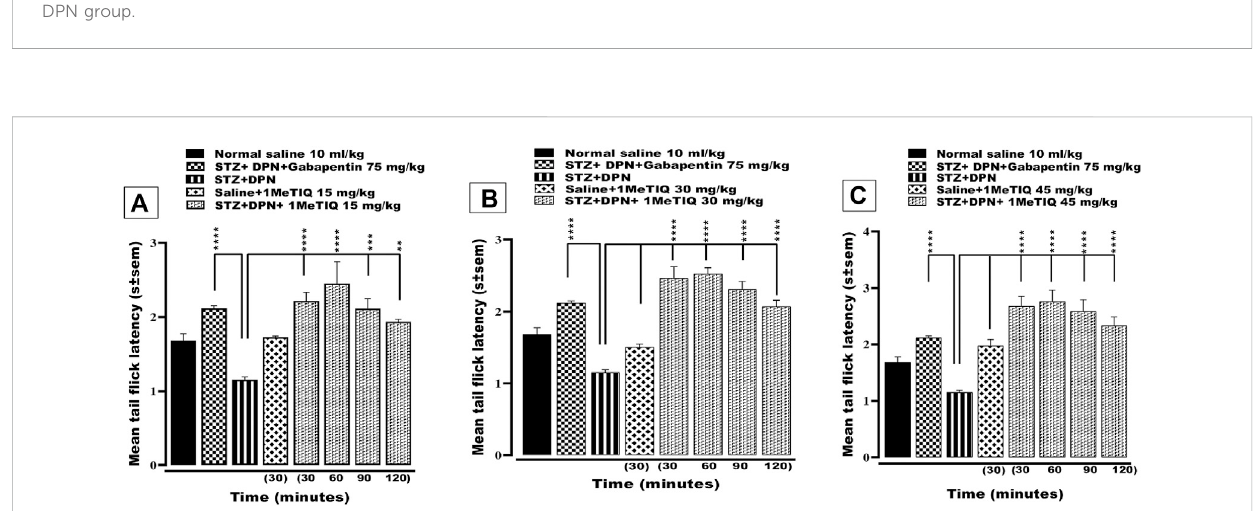
FIGURE 2 Effect of 1-Methyl-1, 2, 3, 4-tetrahydroisoquinoline (15, 30 and 45 mg/kg i.p.) or gabapentin (75 mg/kg) on STZ-induced diabetic thermal hyperalgesia. 4 weeks after STZ administration, mice exhibited signi fi cantly reduced response latencies in the tail immersion test. (A, B) and (C) , an effect that was negated by both gabapentin and 1MeTIQ. Data are presented as mean ± SEM and the abscissa coordinate represents the time after treatment. ** p < 0.01, *** p < 0.001, **** p < 0.0001 when compared to the STZ + DPN